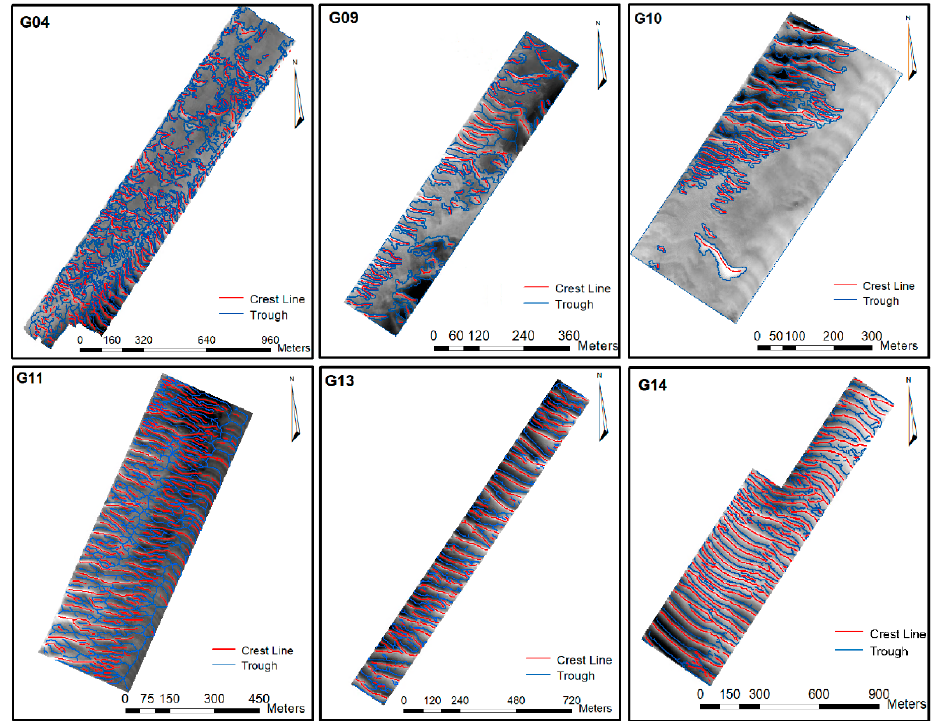
Figure 10. The salient features of the underwater dunes identified for sectors G04, G09, G10, G11, G13, and G14 of the Northern Traverse. The salient features (crest lines in red and troughs in blue) are superimposed on the DBM.